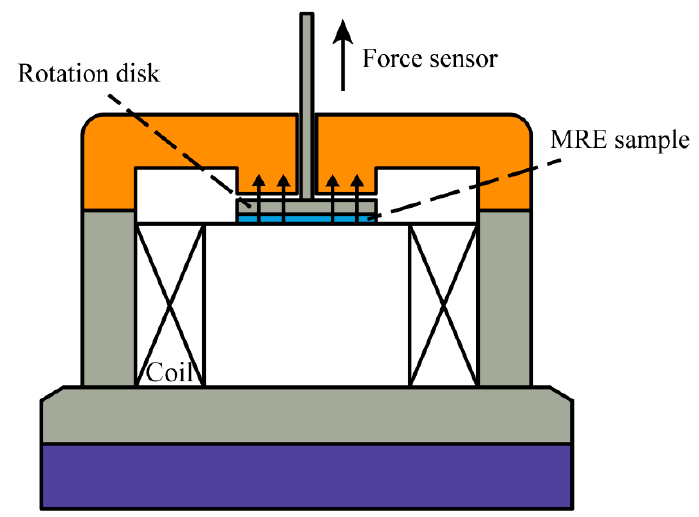
Figure 1. Principle diagram of the magnetorheological (MR) device of the rheometer.